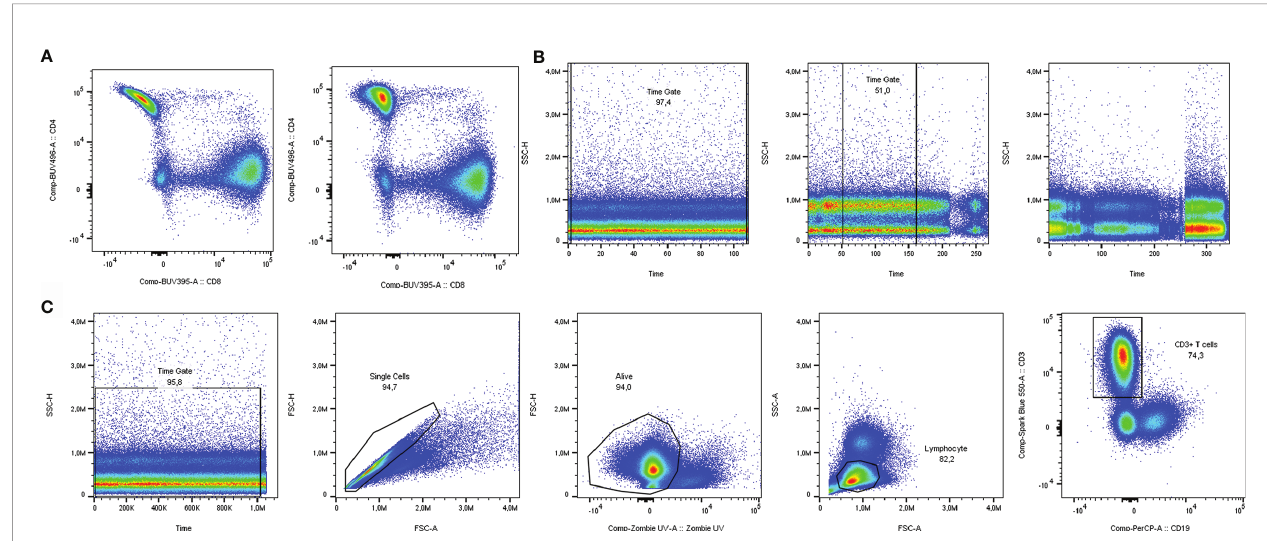
FIGURE 2 | Manual quality control and data cleaning. (A) Unmixing results using single stain reference controls for CD4 on beads (left) vs. cells (right). (B) Examples of time gates where all cells could be included (left), the best part was included (middle) and a sample was excluded from analysis due to inconsistent fl ow rate (right). (C) Pregating strategy to include solely clean T cell data in downstream